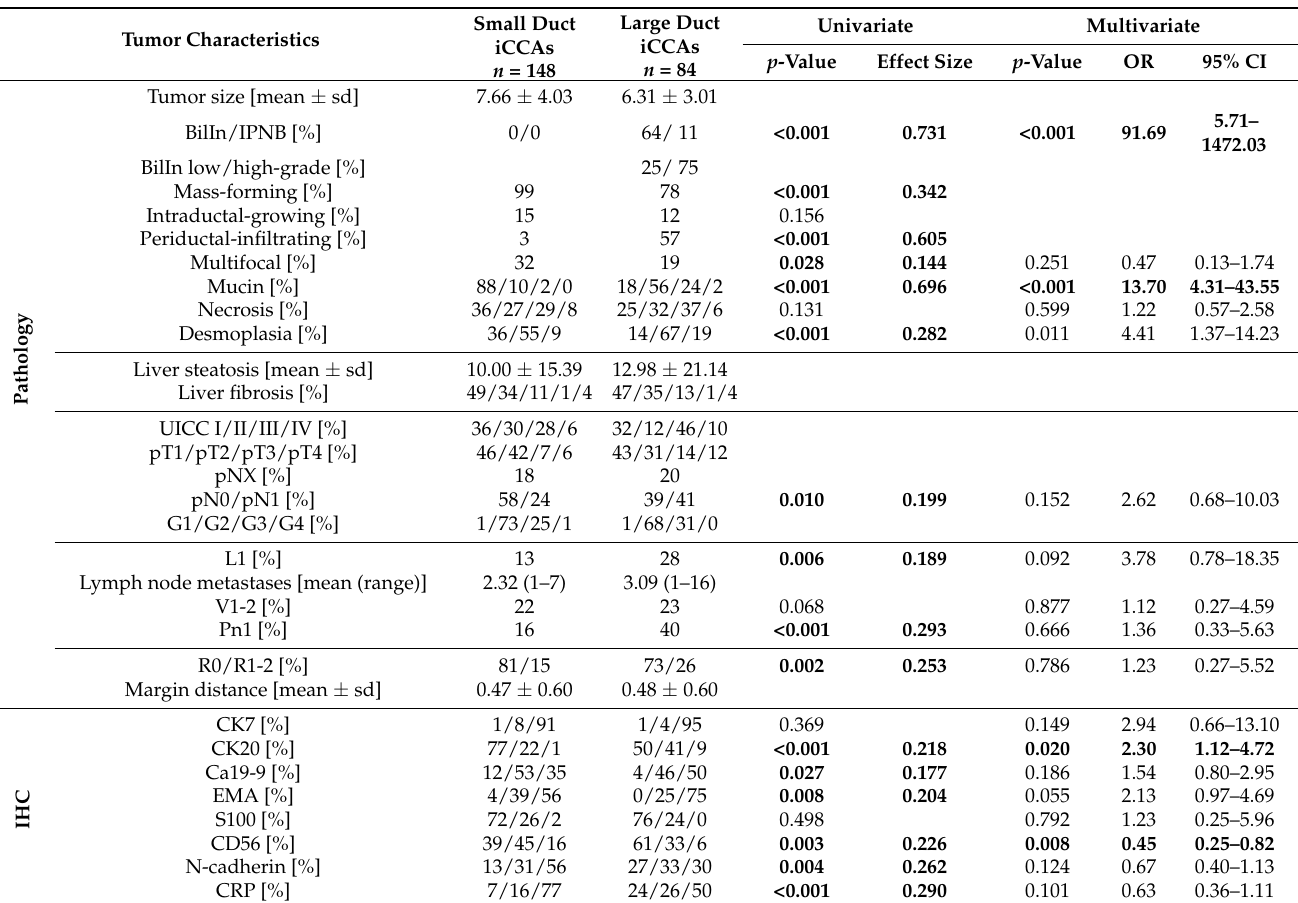
Table 3. Histology and immunohistochemistry of iCCA